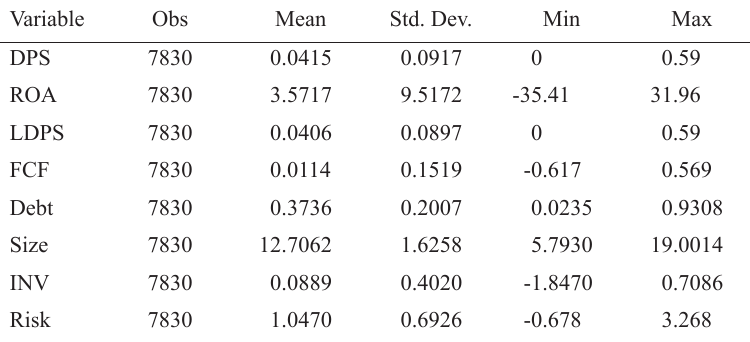
Descriptive Statistics of the Variables